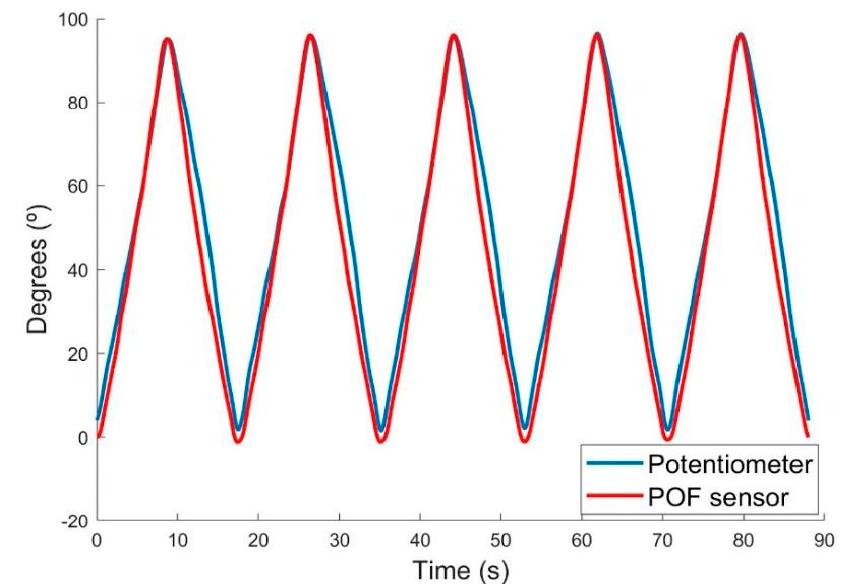
Figure 5. Results of the dynamic test for the 18°/s velocity. The blue line represents the potentiometer response and the red one represents the POF sensor response, in degrees.